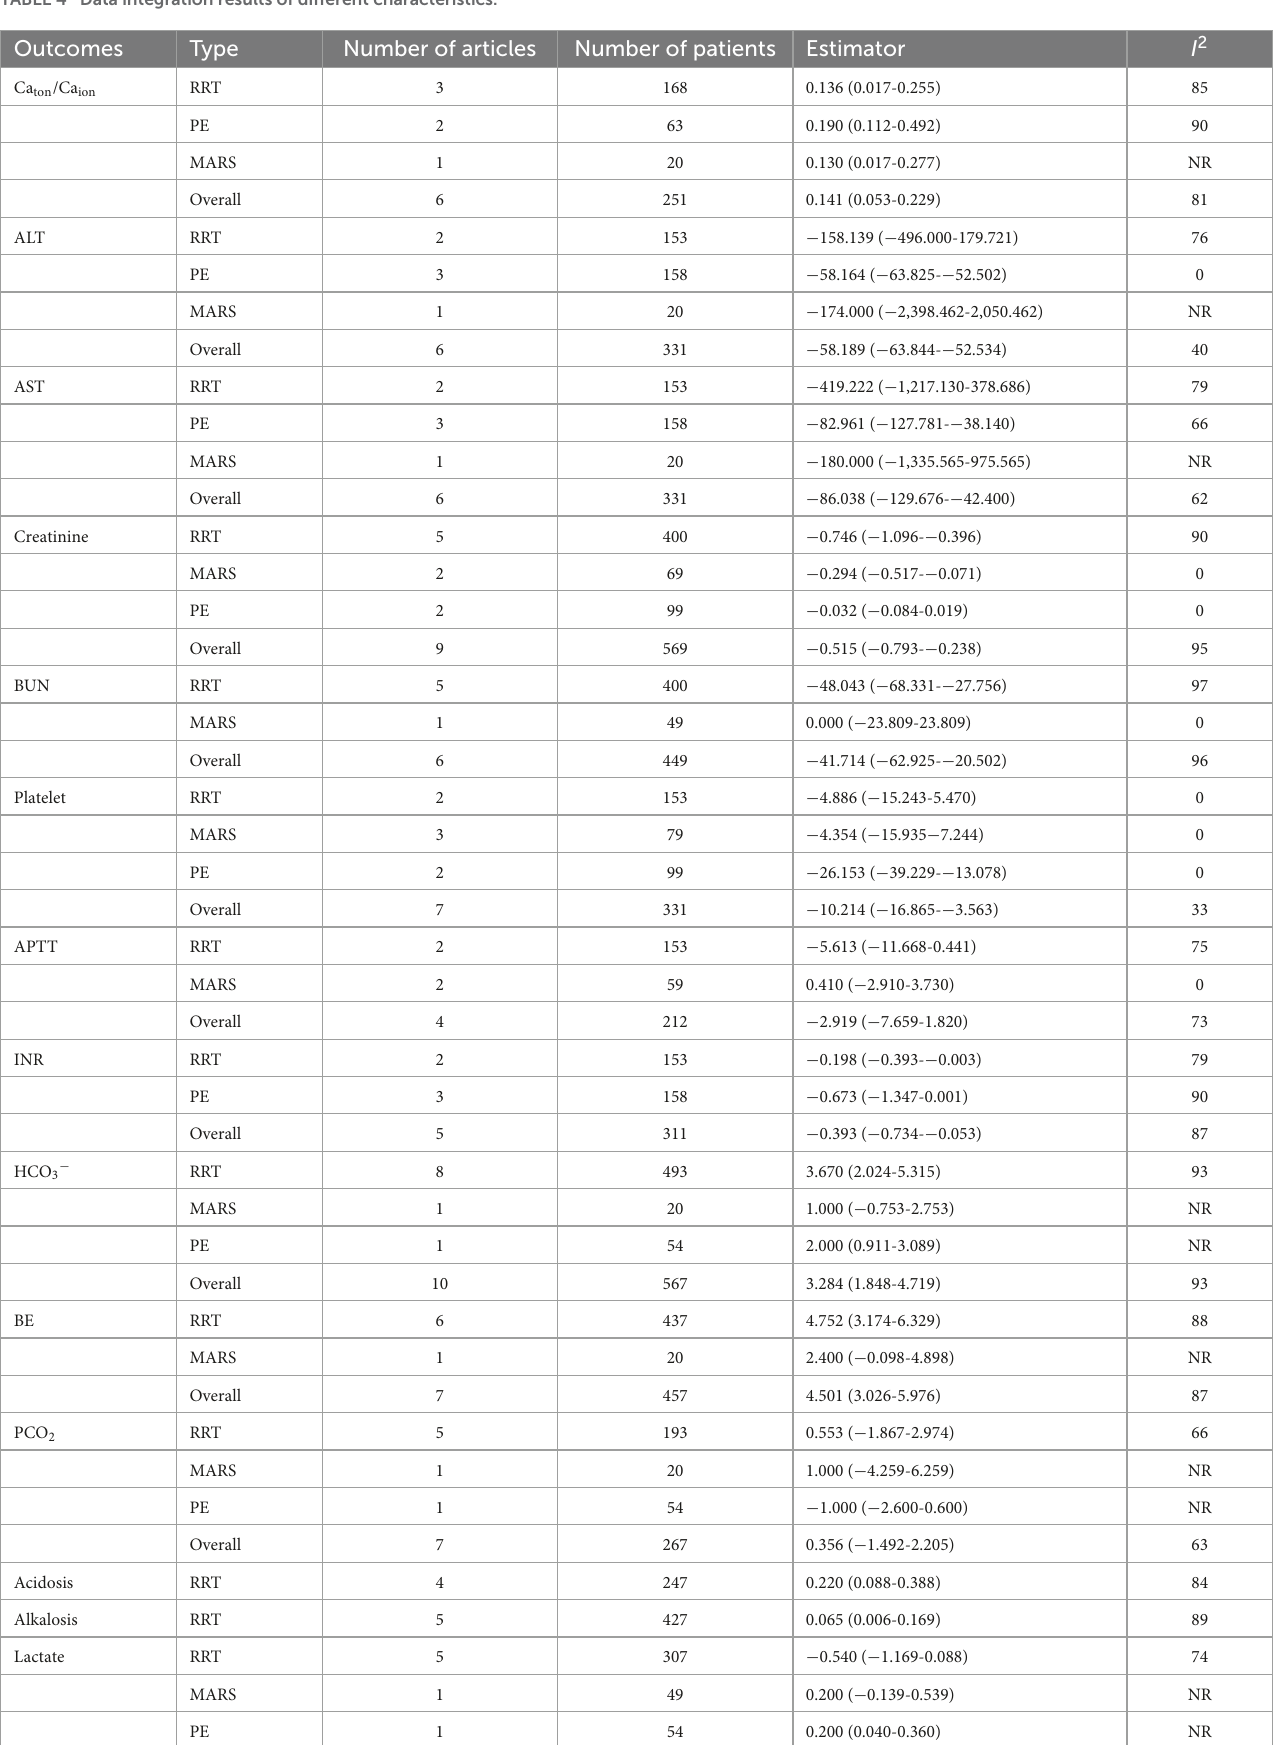
TABLE 4 Data integration results of different